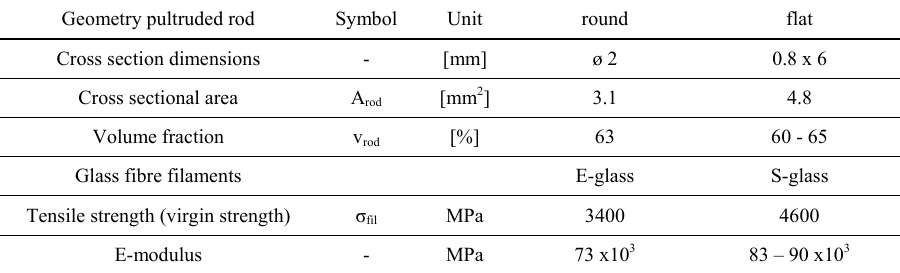
Table 3: Main properties of the round and flat pultruded glass fibre rods, [10, 11]. Geometry pultruded rod Symbol Unit round